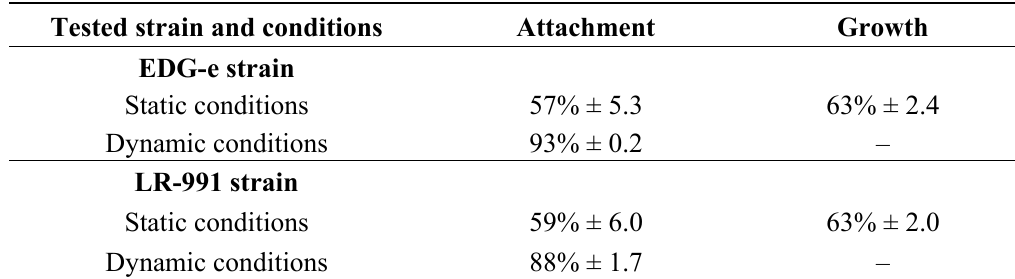
Table 2. Reduction in bacterial adhesion on modified